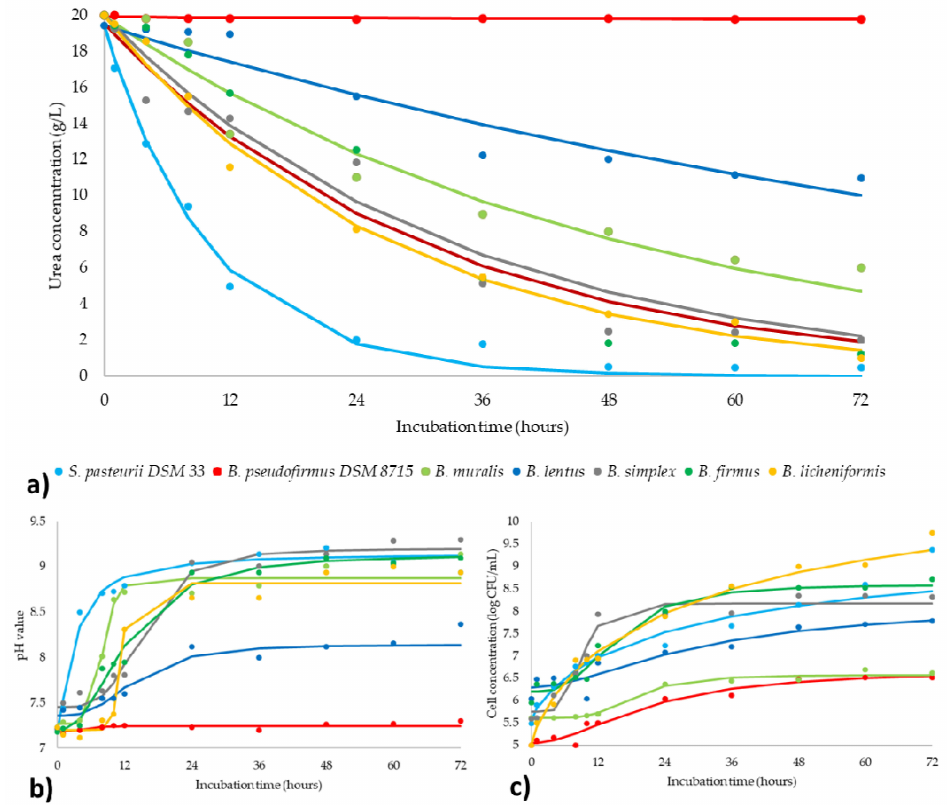
Figure 4. Kinetic study of ( a ) ureolysis process; ( b ) pH value; ( c ) bacteria concentration (markers signify the experimental data; lines indicate predictive